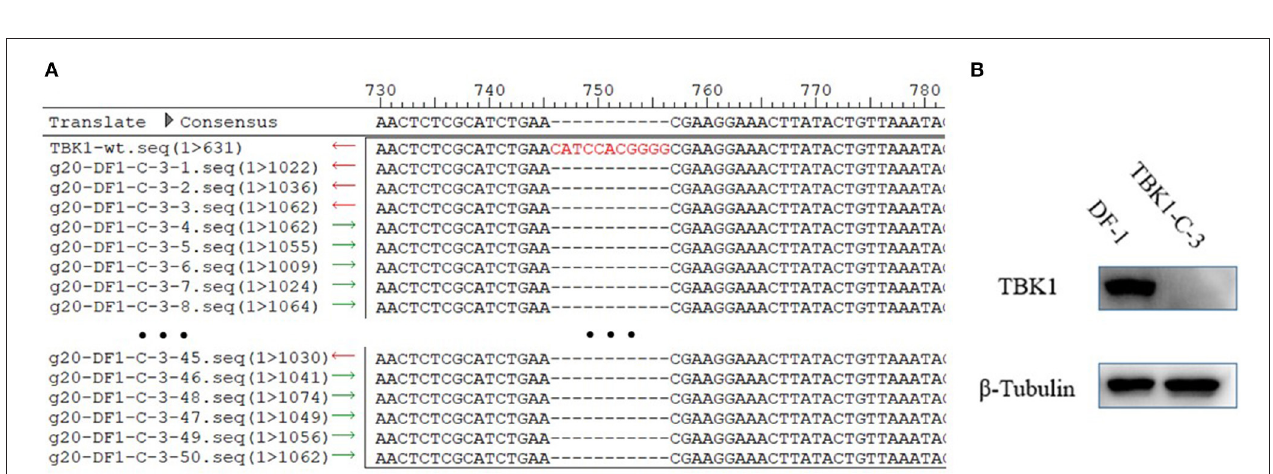
FIGURE 3 | Knockout of chTBK1 to Block chSTING-mediated IFN- β Production. (A) Proliferation of DF-1-TBK1-C3 cell line (TBK1 − / − ) using CCK8 assay. (B) Knockout of chTBK1 blocks IFN- β production induced by chSTING overexpression. DF-1 or TBK1-C-3 cells were cotransfected with 100 ng/well chSTING or empty vector with 100 ng/well pGL-chIFN- β -Luc with 20 ng/well pRL-TK. Luciferase assays were performed 24h after cotransfection. (C–E) DF-1 or TBK1-C-3 cells were transfected with 100 ng/well chSTING plasmid, 24h after transfection, the cells were harvest, and IFN- β (C) , Mx-1 (D) , and PKR (E) mRNAs were analyzed by qRT-PCR. Asterisks indicate a significant difference ( p < 0.05) as determined by Student’s t -test.